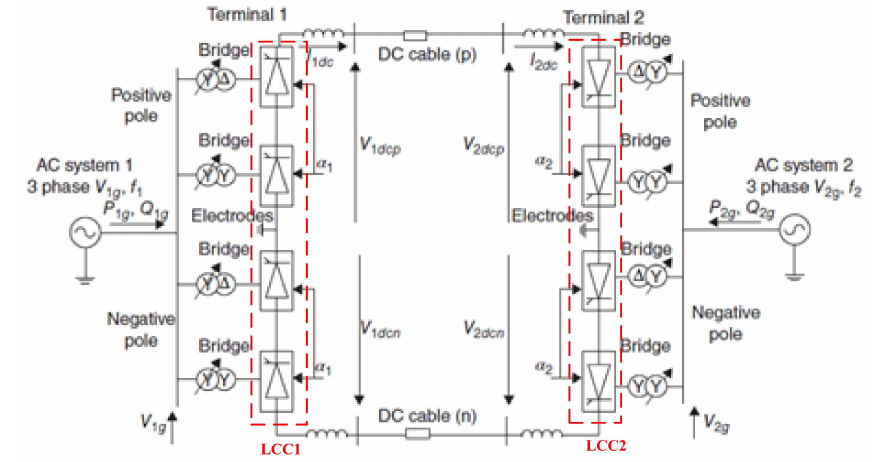
Figure 2. A typical high-voltage direct current system (12-pulse bipolar with ground